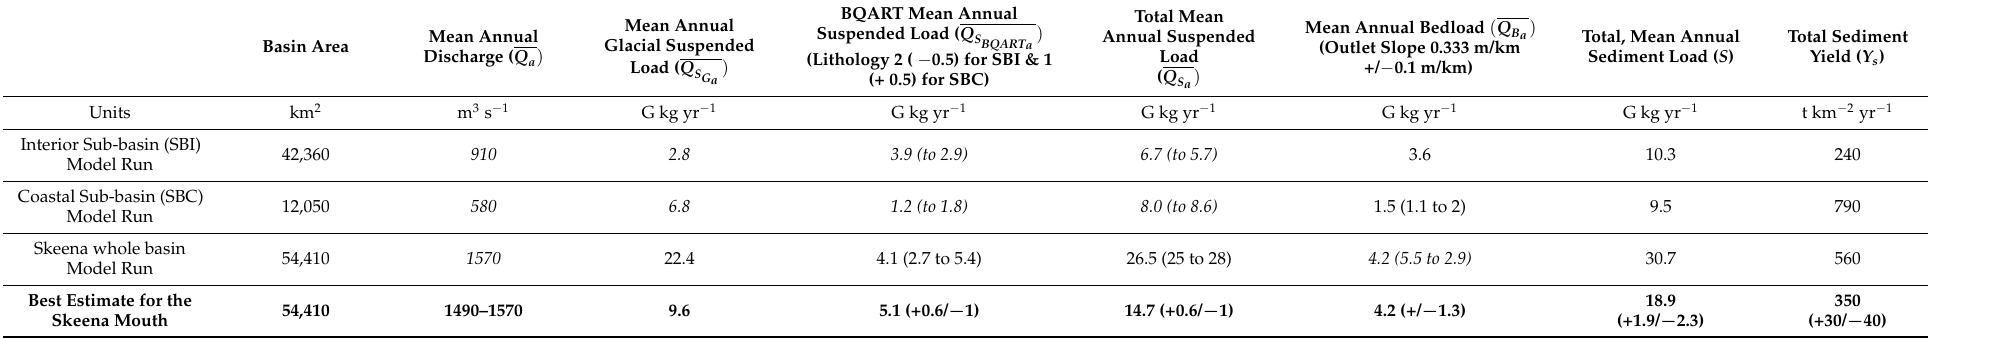
Table 1. Modelled reference (1981–2010) discharge and sediment yield (30-year averages) at the Skeena River mouth using measured ECCC climate normals to drive HydroTrend simulations. Results are presented for sub-basin simulations and whole basin approach. Bracketed values are used to show error/uncertainty around estimates with the greatest uncertainty. Results in the Table 1 are displayed to the nearest 10 m 3 s − 1 and 0.1 G kg yr − 1 . Values used to calculate the best estimate for the Skeena mouth are italicized (SBC and SBI combined for suspended load 1-basin used for